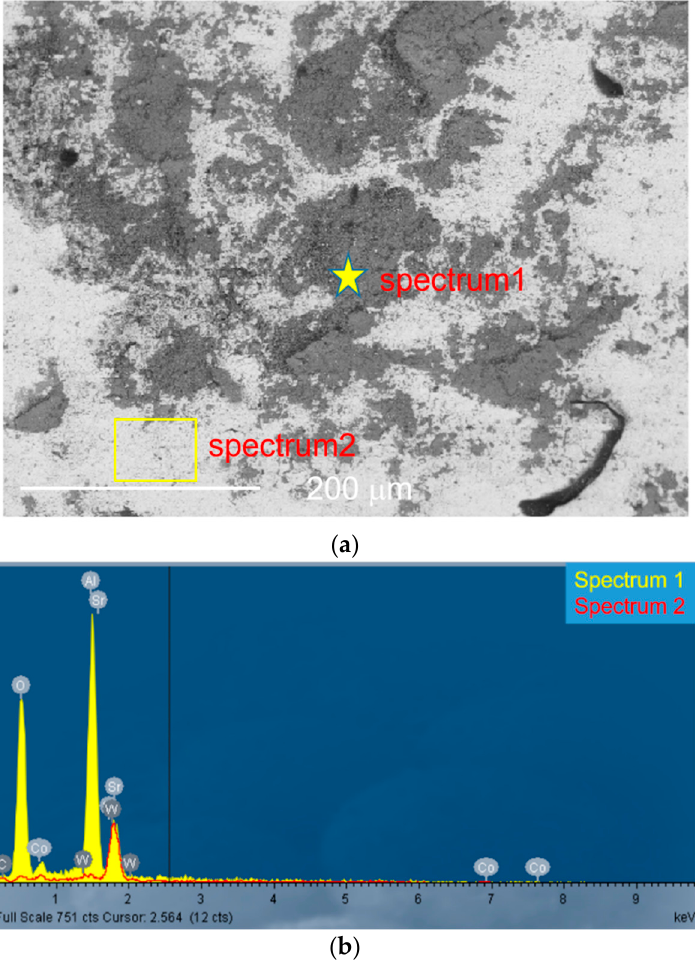
Figure 17. SEM micrograph ( a ) and EDS analysis ( b ) of WC-Co-Cr.